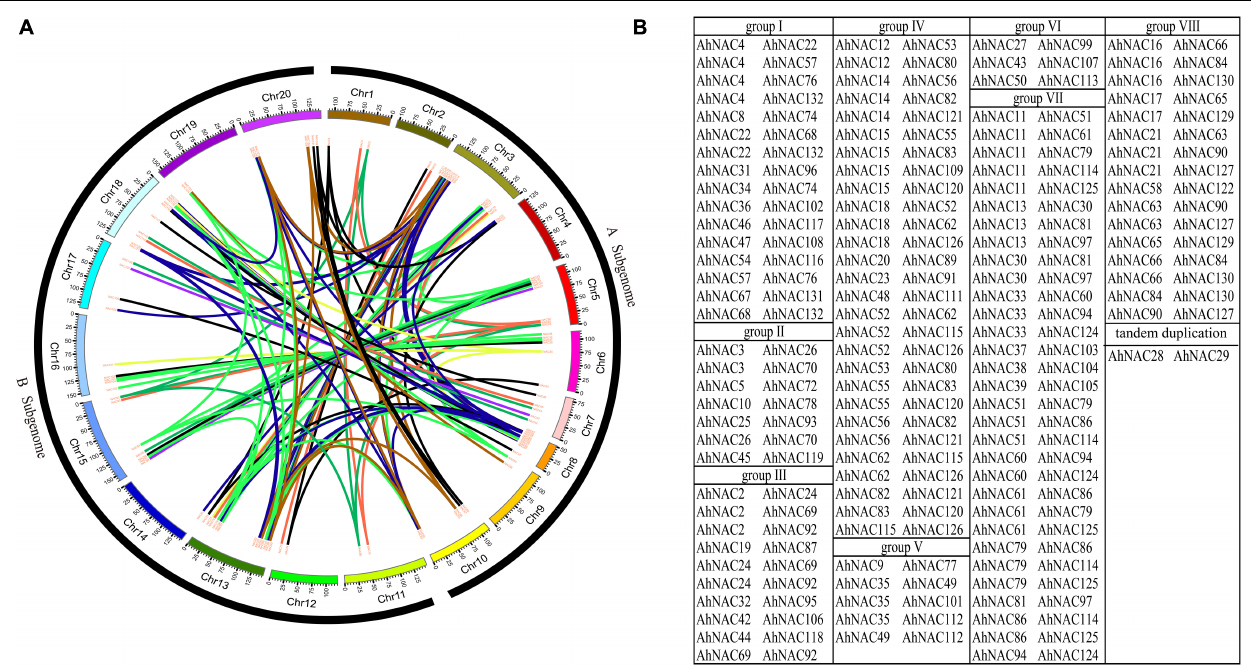
FIGURE 3 | Collinearity analysis results indicating that a number of duplication events existed in AhNAC genes. (A) The colinear relationship among AhNAC genes is shown as a circle map. The red line indicates the duplication events between pairs, and the different-colored bars represent the different chromosomes. (B) The statistics of duplicated gene pairs according to their assigned groups. Black represents group I, red represents group II, green represents group III, blue–black represents group IV, yellow represents group V, purple represents group VI, light green represents group VII, and brown represents group VIII.